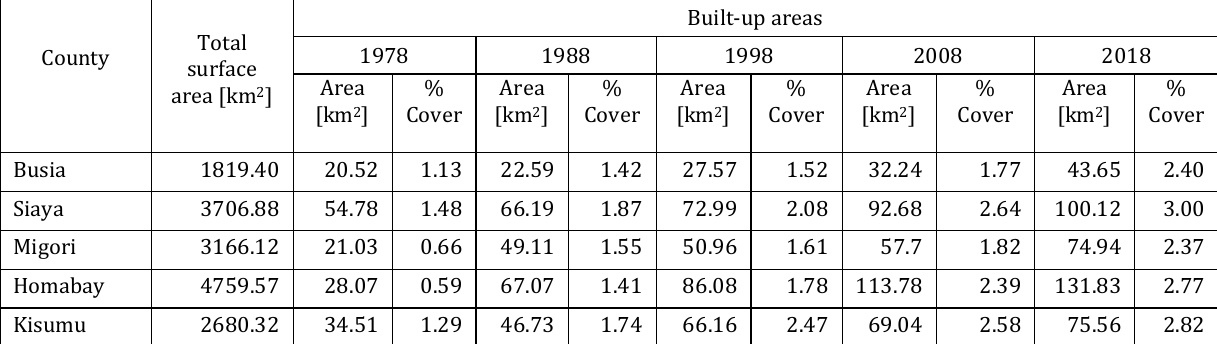
Table 2. County-wise statistics of the built-up areas in the Kenyan Lake Victoria from 1978 to 2018